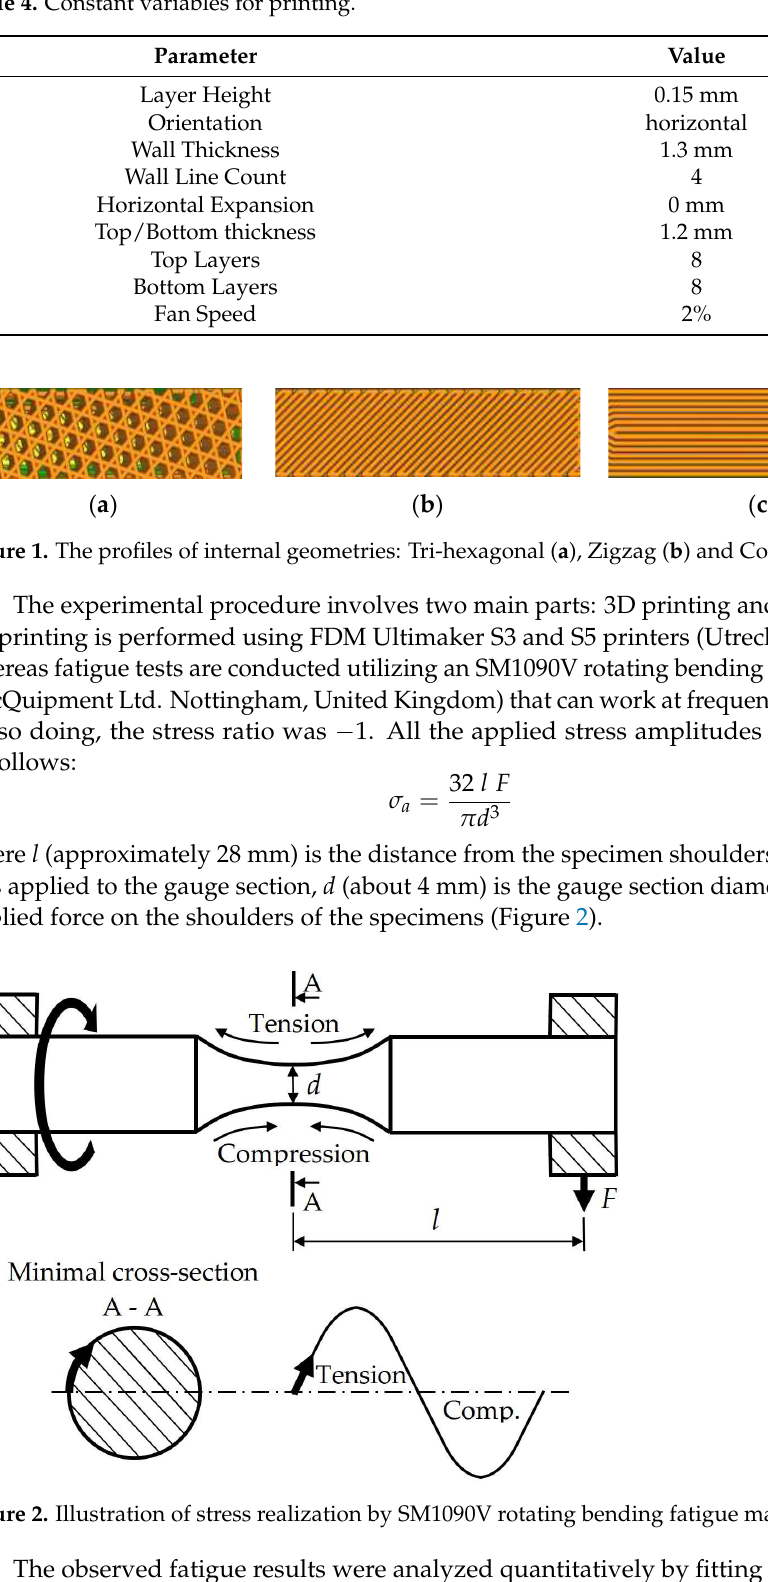
Table 3. L 9 Orthogonal Array.